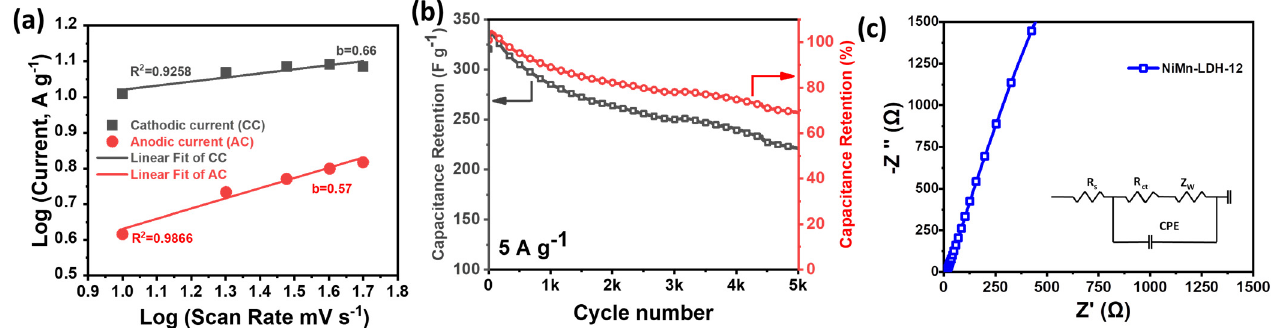
Figure 5. ( a ) The plot of anodic and cathodic peak current responses of NiMn-LDH-12 against the log of different scan rates with a linear fit analysis; ( b ) The cycling stability of NiMn-LDH-12 at a constant current density of 5 A g − 1 with inset showing representative charge-discharge curve after fixed intervals; ( c ) EIS based Nyquist plot for hollow sphere NiMn-LDH-12.